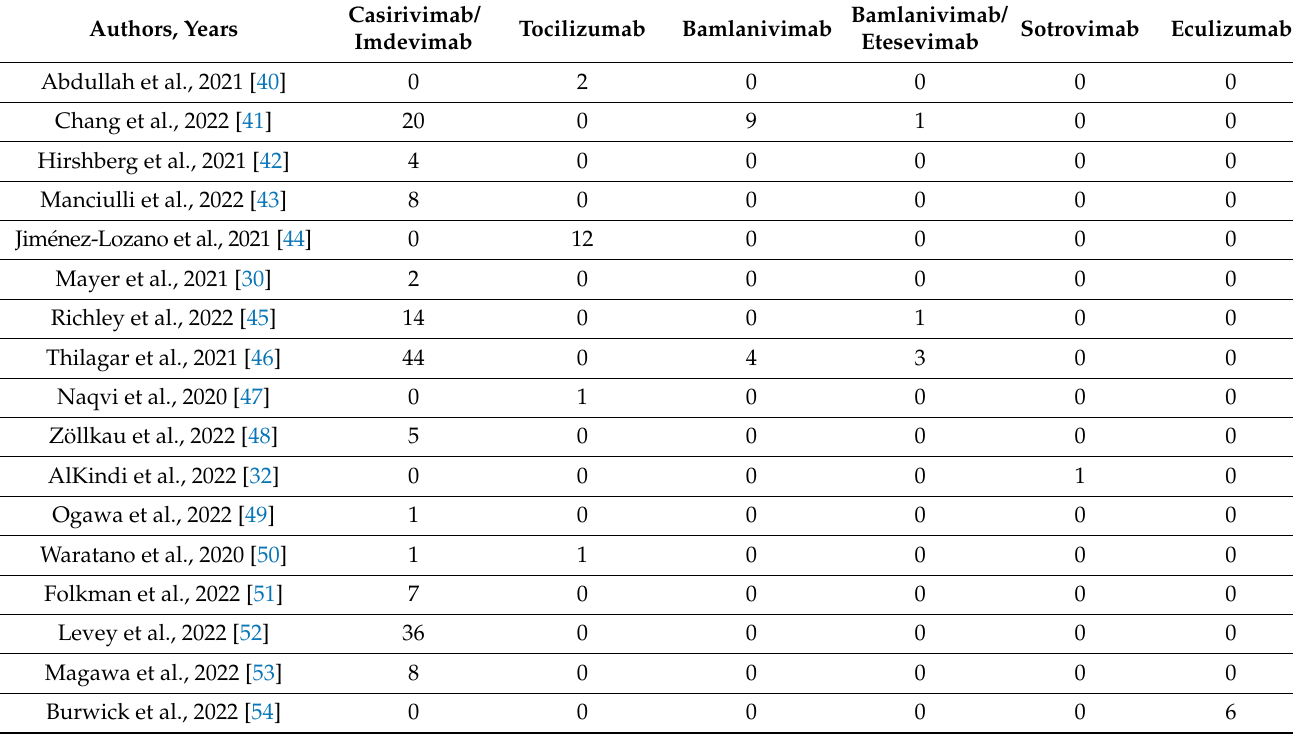
Table 2. Monoclonal antibodies used in the included studies.